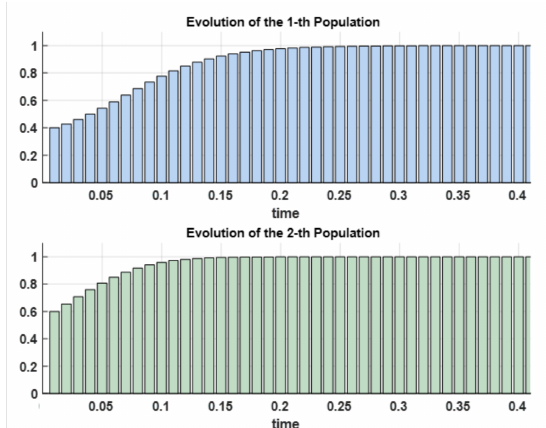
Figure 3. Evolution path of the system under government supervision.